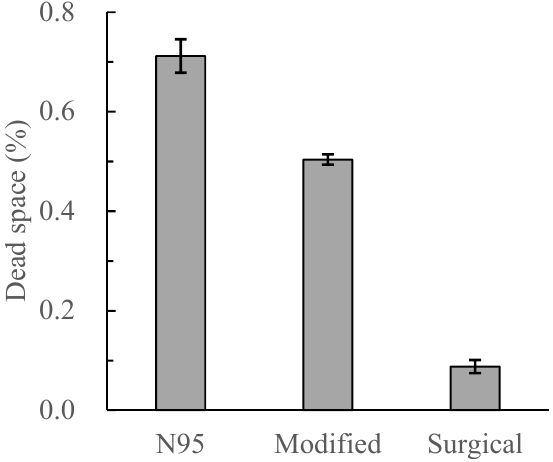
Figure 9. Dead space of three face masks (exhaled CO 2 concentration: 1.78%).